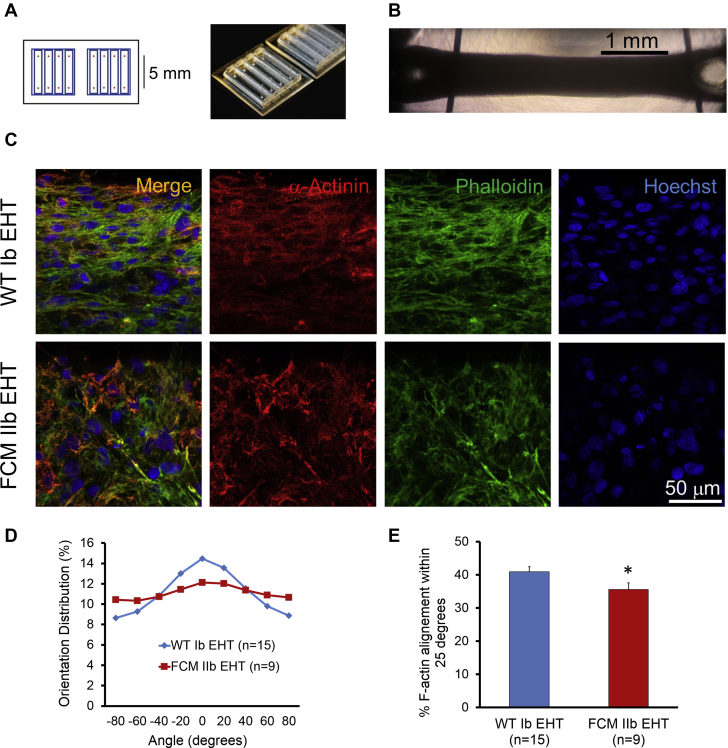
Generation and Characterization of Patient-Specific EHTs(A) Schematic (left) and photograph (right) of polydimethylsiloxane molds used to create engineered heart tissue (EHTs). (B) Bright-field image of EHTs in culture. Vertical bars are pins used to prevent EHTs from migrating out of the mold. (C) EHT immunofluorescence with α-actinin, f-actin (phalloidin), and nuclear staining. (D, E) Quantitative analysis of cytoskeletal alignment of EHTs conditioned with static stress. Vector of stress conditioning is parallel to EHT edge (horizontal). *p < 0.05 (Student’s t-test). Error bars indicate SEM.